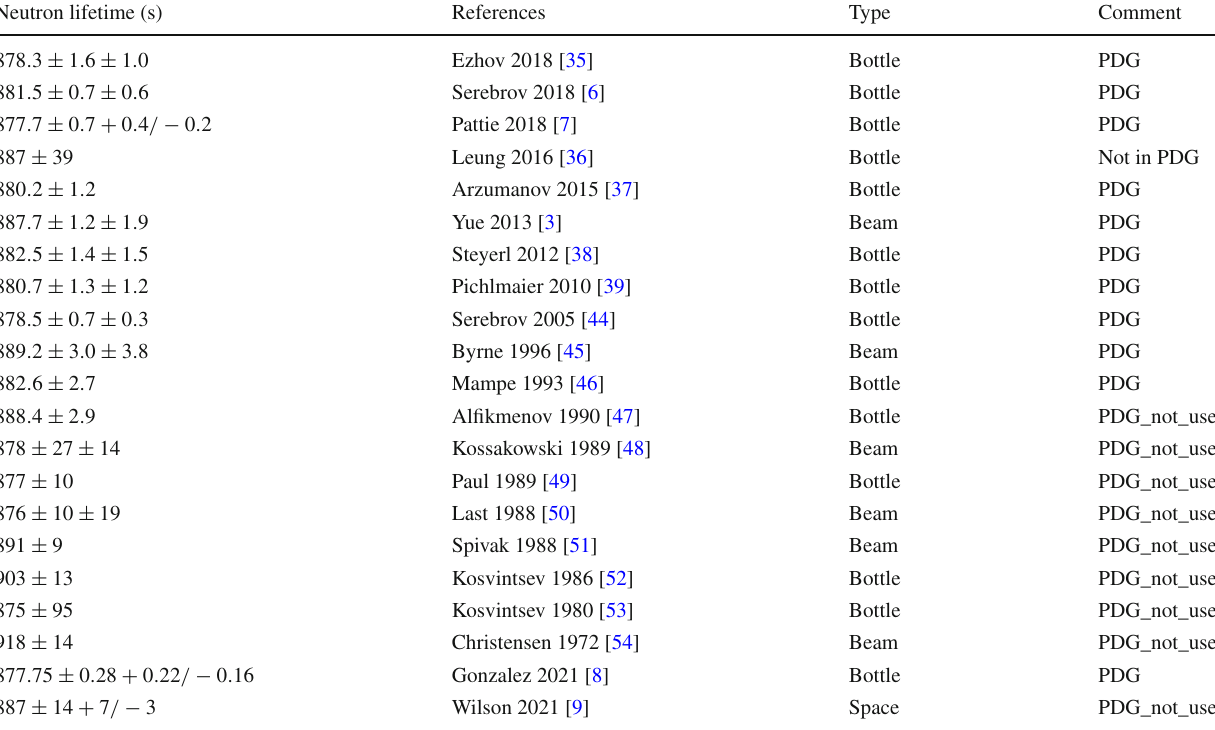
Table 1 21 neutron lifetime measurements from PDG. The taxonomic approach of Not_in_PDG, PDG and PDG_not_used for analysis is similar to Rajan and Desai [23] Neutron lifetime